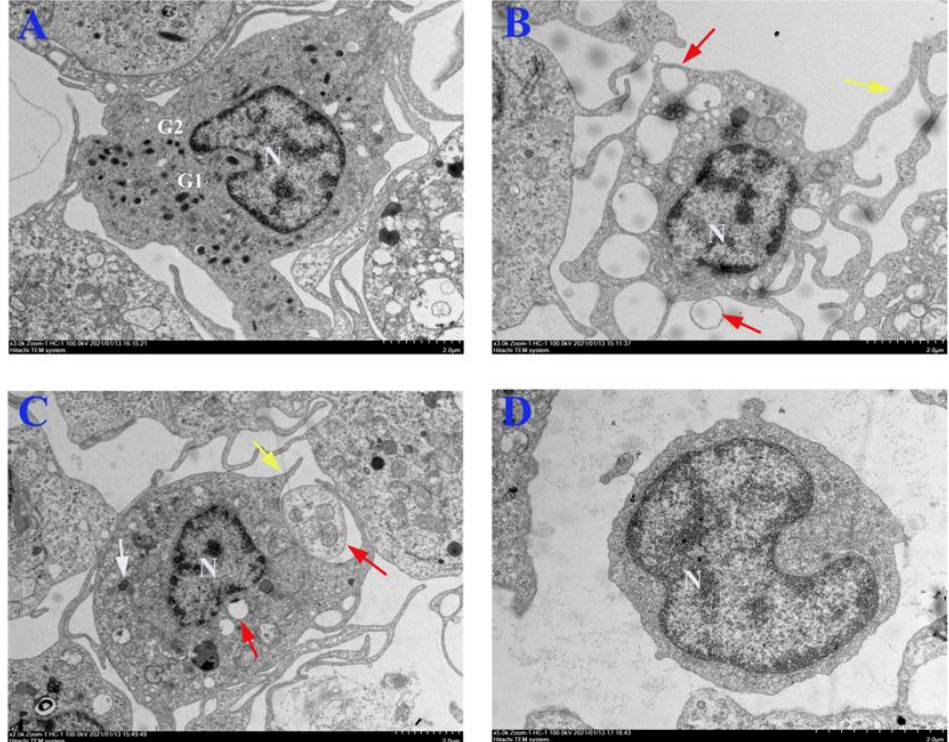
Figure 2. Ultrastructure of the PerC cells in flounder. ( A ) Granulocytes; flounder peritoneal exudate showing first granule-type (GI) and second granule-type (G2) granules; ( B ) dendritic cells; ( C ) macrophages; ( D ) lymphocytes. N represents the nucleus; white arrows indicate lysosomal, yellow arrows indicate pseudopod-like or short protrusions, and red arrows show vesicles inside or released from the cells. Bar of both panels: 2 μm.